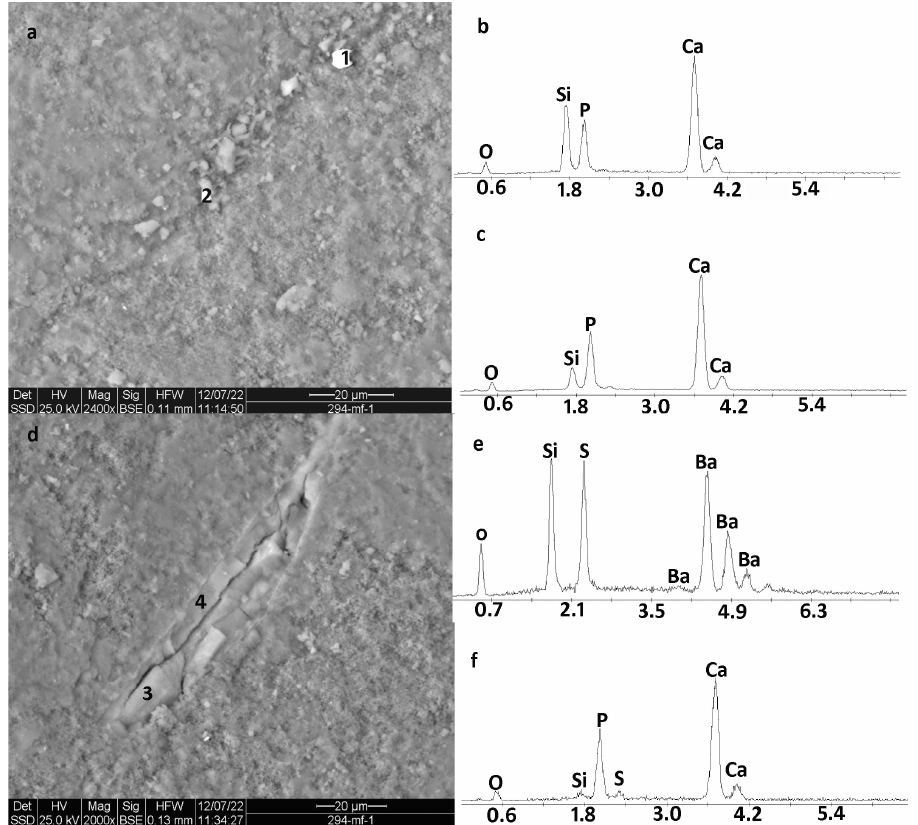
Figure 15. ( a ) The SEM picture of the inclusions in the chert rock, 1 and 2 denote the location of the measurements; ( b ) the results of measurements in point 1; ( c ) the results of measurements in point 2; ( d ) the second example of the SEM picture of the inclusions in the chert rock, 3 and 4 denote the location of the measurements; ( e ) the results of measurements in point 3; ( f ) the results of measurements in point 4.